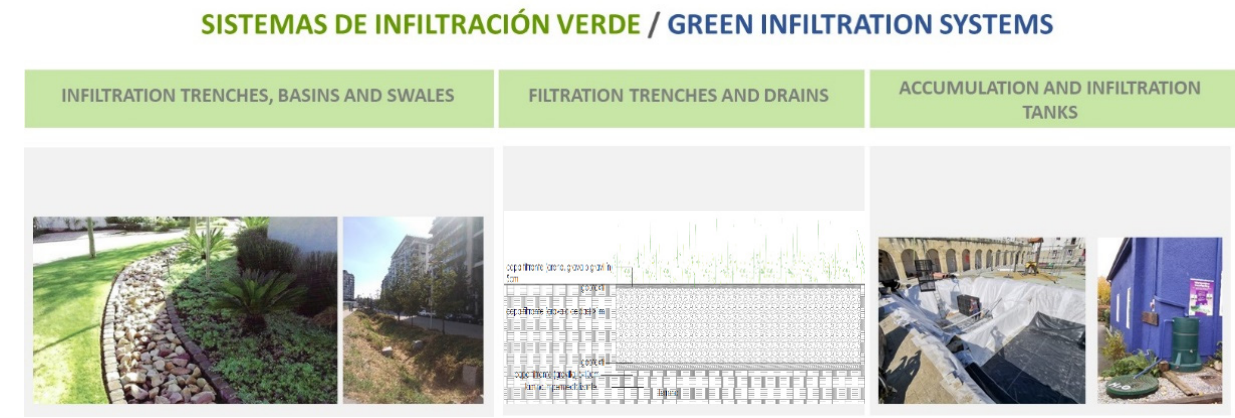
Figure A5. Types of green infiltration systems (table and images by the authors, except the first image of infiltration trench [67]).